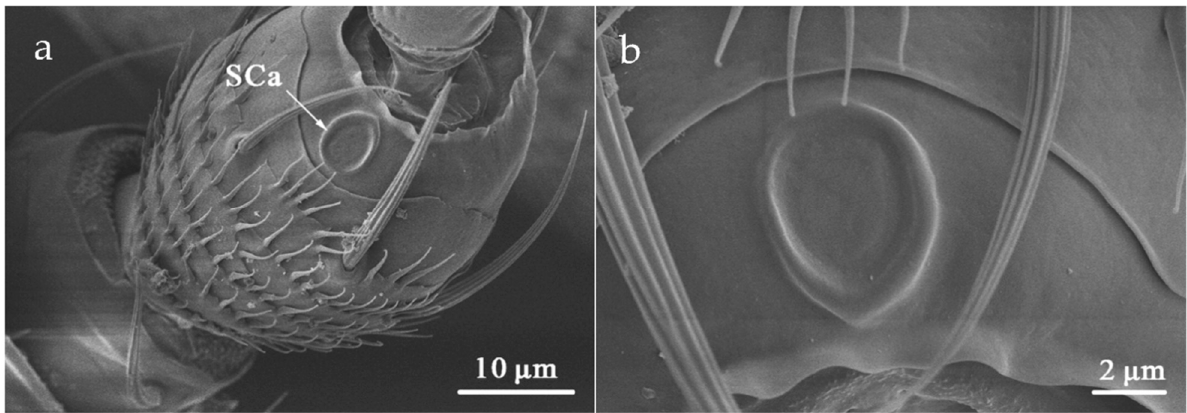
Figure 10. Sensilla campaniformia (SCa) on the pedicel ( a ) and shown at higher magnification ( b ) in S. kaszabi .